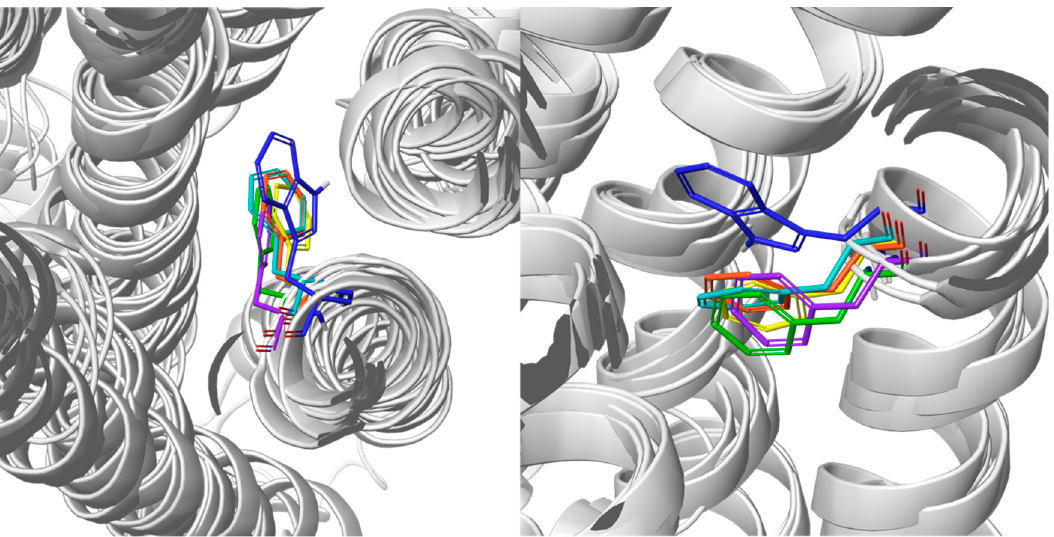
Figure 3. Changes in heteroatom-to-heteroatom distance between R119 3.50 and D118 3.49 (“aspartate cage”) for apo ( upper panel ) and CB148 complexes ( lower panel ) during the 10 ns MD simulations. For colored graphs, please refer to the online version of this paper.